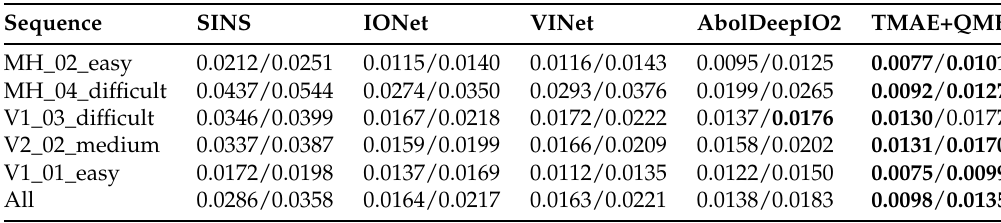
Table 6. Comparison of MAE/RMSE for magnitude of translation change over 10 IMU frames using the test sequences from EuRoC MAV